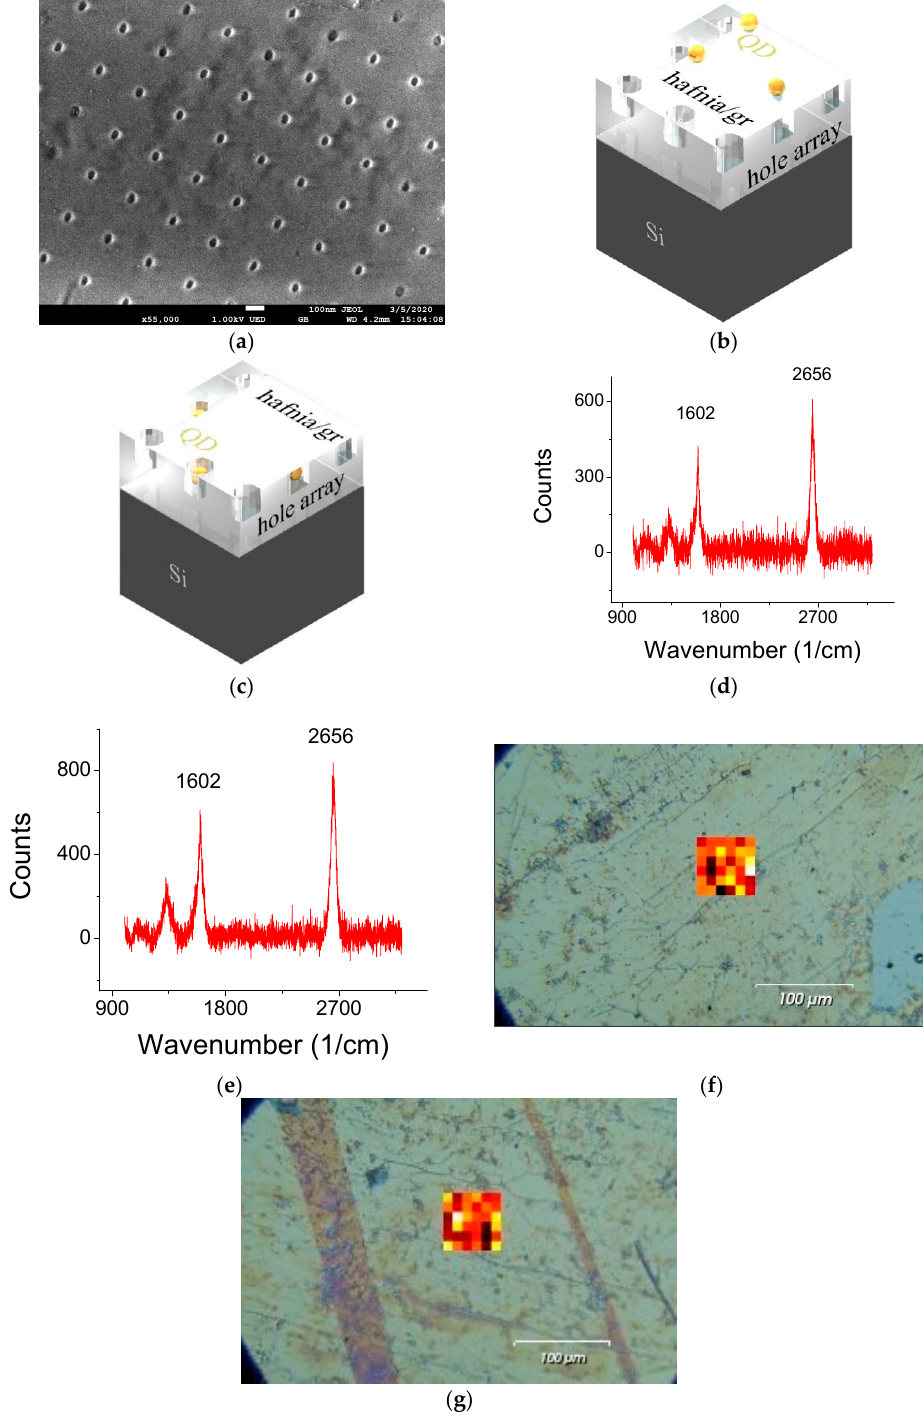
Figure 1. ( a ) Scanning Electron Microscope (SEM) picture of the bare substrate with a hole array. ( b , c ) Schematics of samples S9 (spun QD on top of the graphene/hafnia surface guide) and S8 (spun and wiped QD under the graphene/hafnia guide). ( c ) Typical Raman spectra taken with a 2 mW, 633 nm HeNe laser; ( d ) was obtained when the dots were deposited on top of the hafnia/graphene layer, while ( e ) was obtained when the dots were deposited under the graphene. ( f , g ) Raman maps of the graphene’s 2D line for ( f ) top and ( g ) under deposited dots allude to the monolayer nature of the graphene. The 2D intensity values, I 2D , for the black, red and white squares were, 500, 1000 and 3000, respectively. The ratio of I 2D to the intensity of the G line, I G was approximately I 2D /I G = 1.3 throughout the scan. A typical full fluorescence (FL) curve for sample S7 (with 10-hafnia layer on top of the graphene) exhibits a 470 nm line that is attributed to color centers of the 10 nm hafnia on graphene (Figure 2a). The line is missing from sample S2 that lacks the hafnia layer (Figure 2b), yet coated with a 250-nm- thick PMMA on top of the graphene acting as a surface waveguide. The time-resolved curves, shown below, were obtained with a bandpass filter between 500 and 700 nm. ( a ) ( b ) Figure 2. Full fluorescence curves for ( a ) sample S7 with 10 nm hafnia and ( b ) sample S2 without it. A laser cutoff filter was placed at 450 nm.